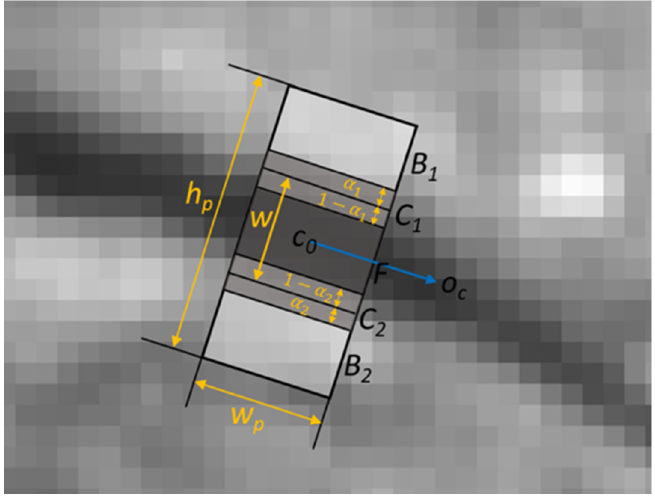
Figure 10. Crack width measurement.